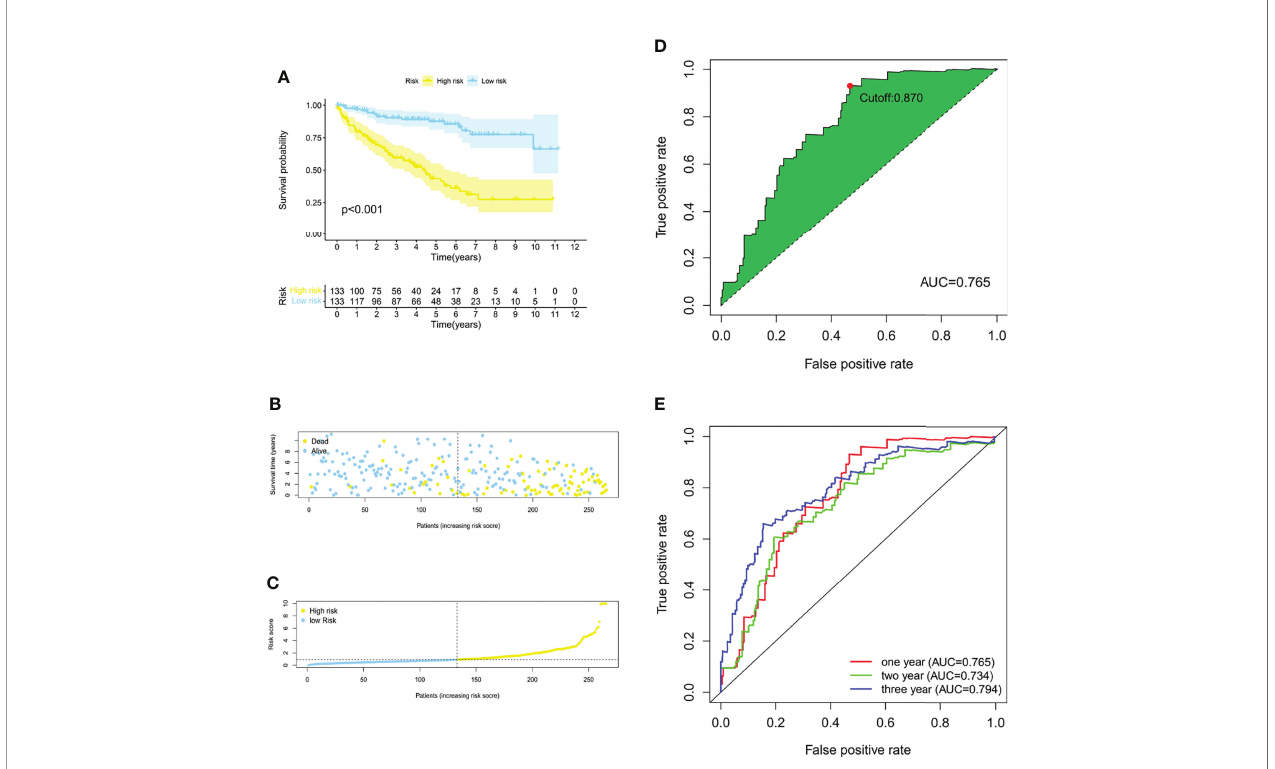
FIGURE 1 | Construction of a risk score model of PRLs in the training group. (A) The Kaplan – Meier survival curves for the two risk groups in the training sets ( p < 0.001). (B) The risk score plot of the training set. (C) Survival time and status of patients in the training set. (D, E) ROC curves at 1, 2, and 3 years, the AUC of the ROC curves, and the cutoff points for the risk